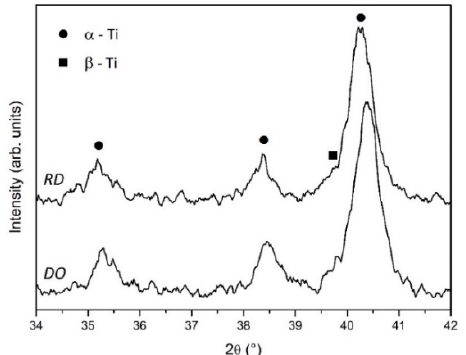
Figure 6. XRD patterns of DO and RD scaffolds. Full dot— α -Ti, full square— β -Ti.